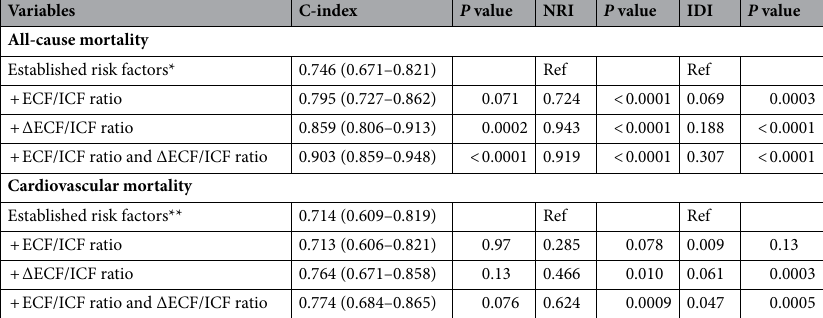
Table 4. Predictive accuracy of the ECF/ICF ratio and/or the ΔECF/ICF ratio for all-cause and cardiovascular mortality. ECF/ICF ratio, extracellular fluid/intracellular fluid ratio; ΔECF/ICF ratio, annual change in ECF/ ICF ratio. *Age, sex, history of cardiovascular disease, creatinine, phosphorus, C-reactive protein, high-density lipoprotein cholesterol, cardiothoracic ratio, and the geriatric nutritional risk index. **Age, sex, history of cardiovascular disease, phosphorus, cardiothoracic ratio, and the geriatric nutritional risk